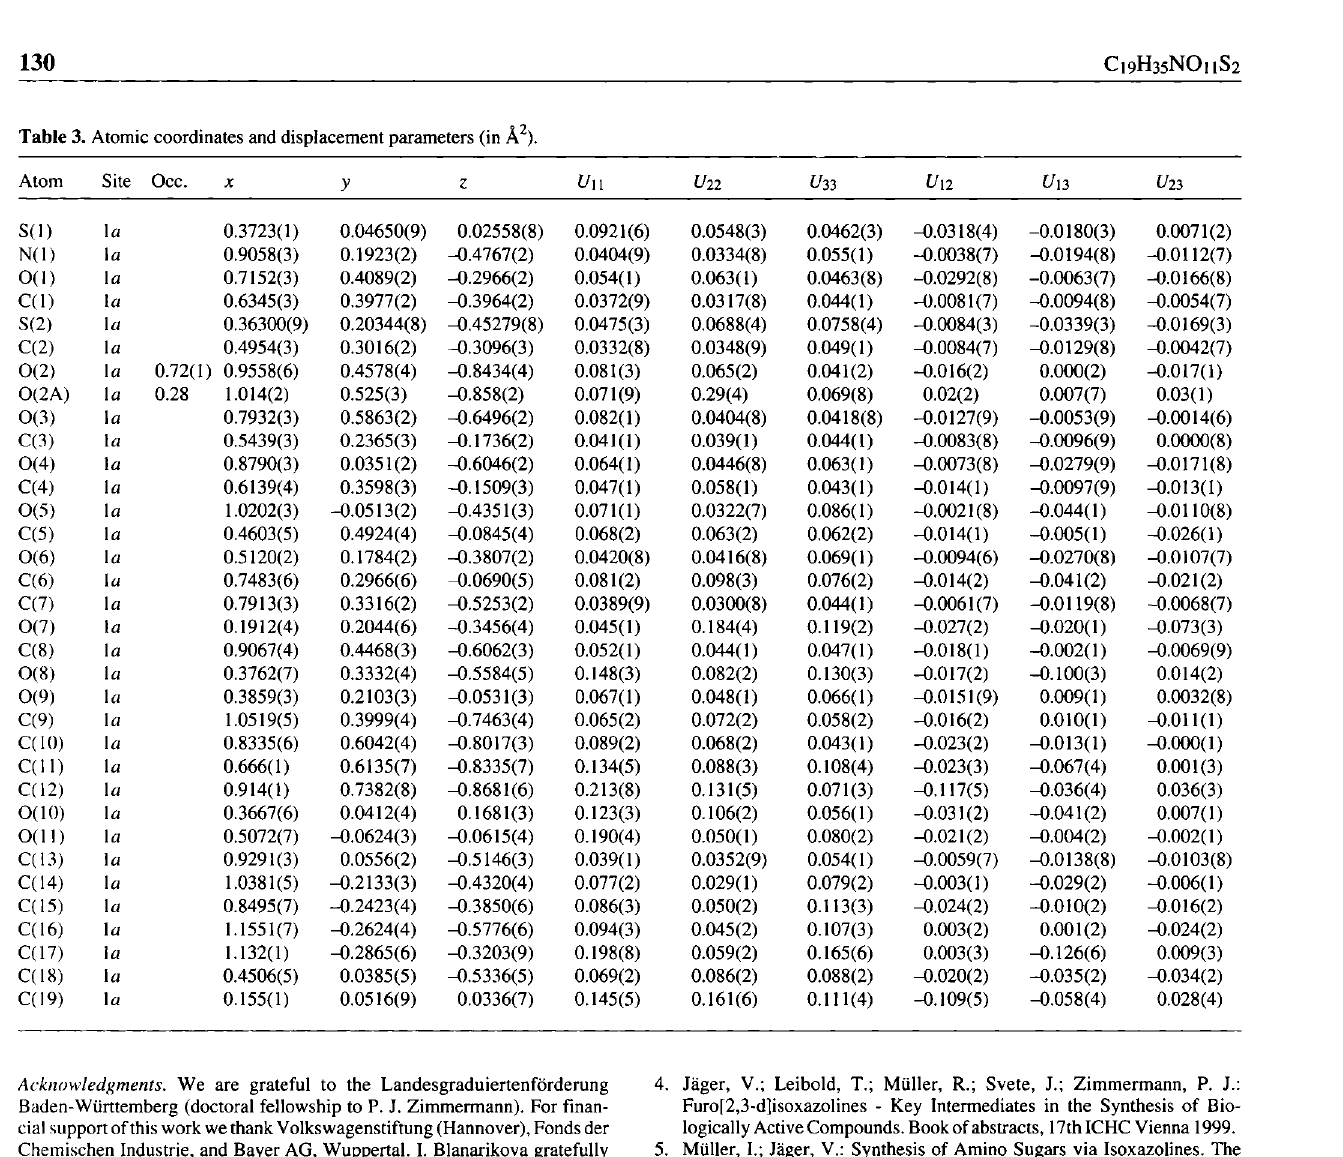
Table 3. Atomic coordinates and displacement parameters (in Ä 2